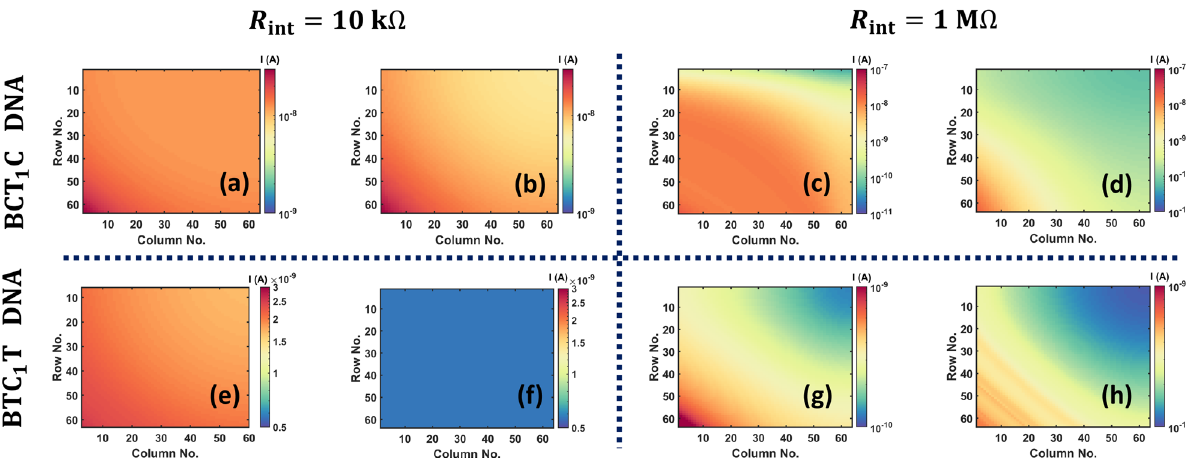
Figure 5. Read-out current distributions (see Eq. (11) for homogenous arrays composed of B-CT 1 C DNA ( a - d ) and B-TC 1 T DNA ( e – h ). The interconnect resistance is 10 kΩ for ( a , b , e , f ) and 1 MΩ for ( c , d , g , h ). Array size is kept fixed at 64 × 64. For panels ( a , c , e , g ), the Fermi energy is at corresponding HOMO level while for panels ( b , d , f , h ), Fermi energy is at (HOMO + 0.2)